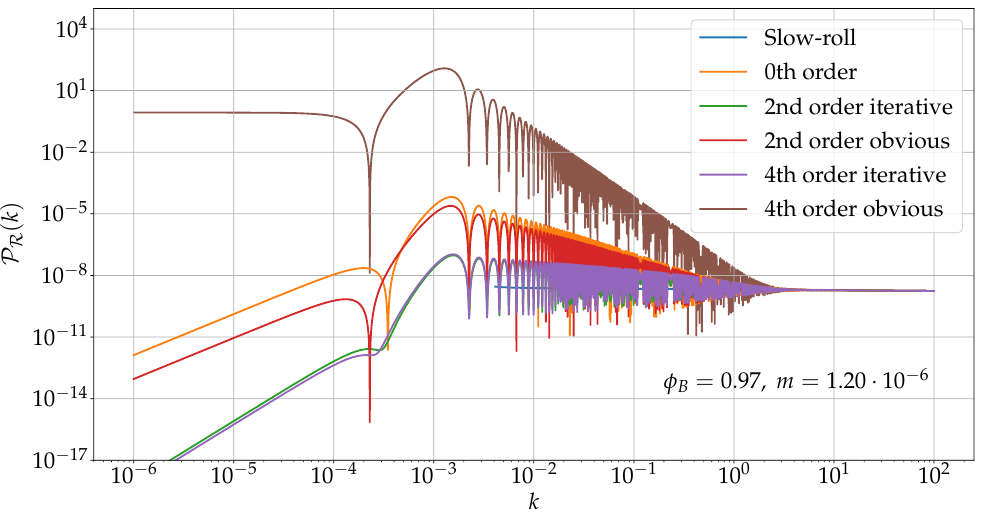
Figure 3. The primordial scalar power spectrum in hybrid LQC for the adiabatic states of lowest orders on the background solution studied in Section 5. Two kind of adiabatic states are considered: the obvious ones and the iterative adiabatic states. The power spectrum obtained with the slow-roll approximation (26) is also shown for